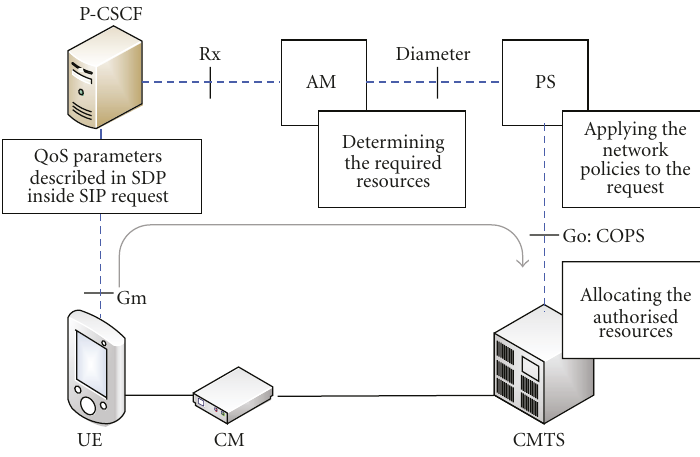
Figure 9: Resource reservation